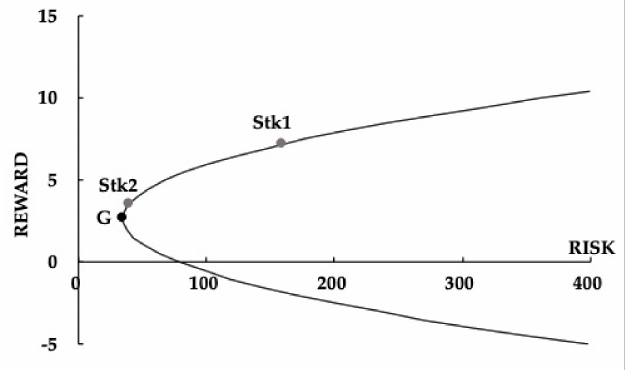
Figure 1. The parabolic portfolio